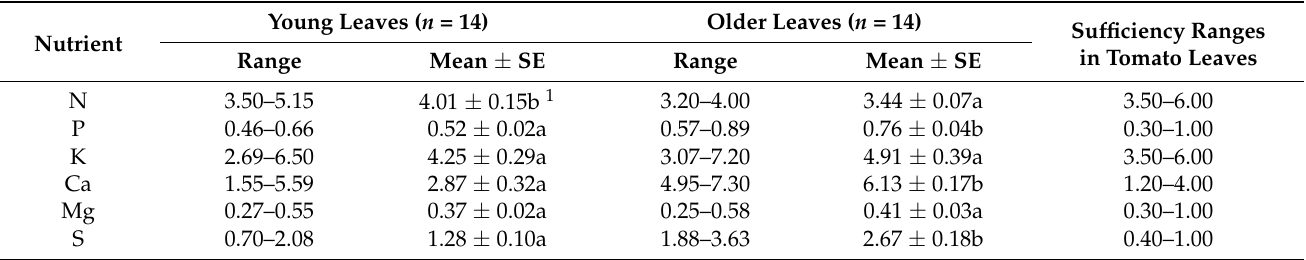
Table 1. Macronutrient concentration (mass %, dry matter) in young and older ‘Beorange’ tomato leaves during the crop cycle from September 2020 to April 2021. Nutrient sufficiency ranges for the youngest fully developed tomato leaves were indicated according to the established reference values [26–28].